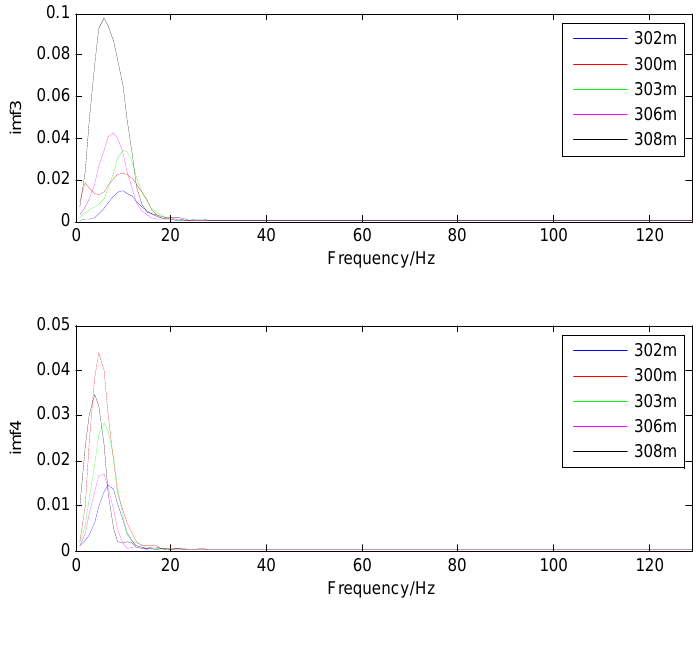
Figure 19. Power spectra of IMF 3 and IMF 4 from different ECG